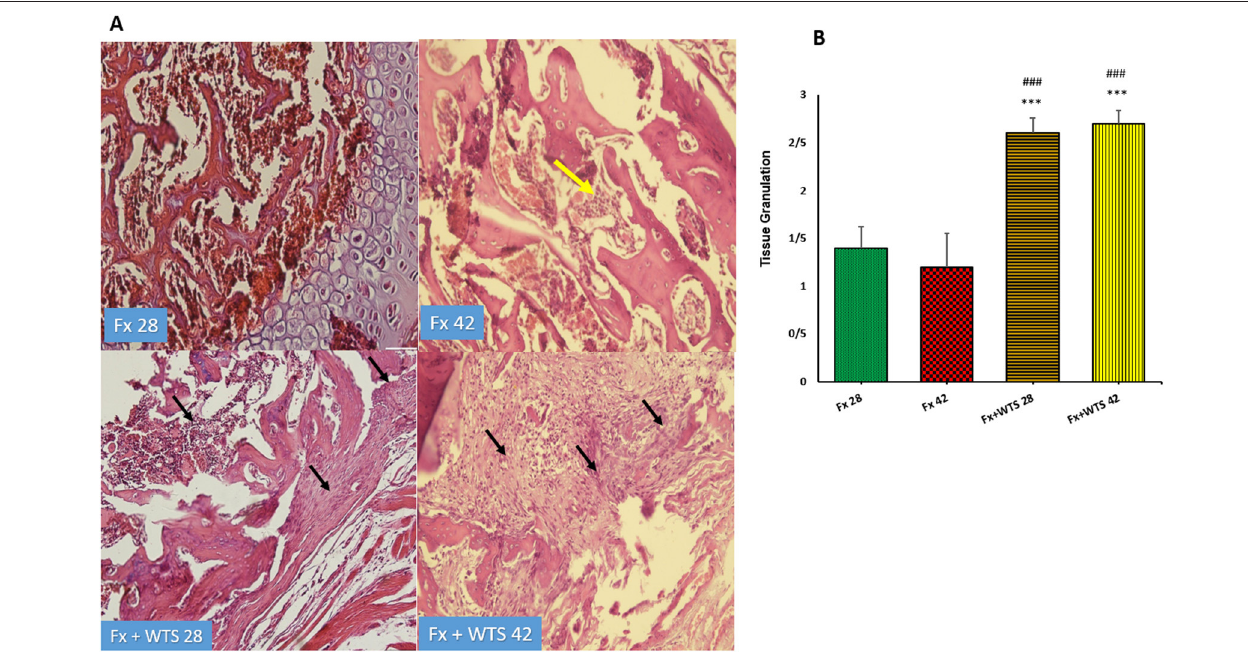
FIGURE 8 | (A) Pathological representation of tissue granulation. In the Fx 28 group, tissue granulation is rare. In the Fx 42 group, the yellow arrow indicates that the tissue granulation has been removed and the bone marrow has been replaced. In the Fx + WTS 28 group, a tissue granulation fracture is observed, which is in the early stages of the healing process (black arrow). In the Fx + WTS 42 group, the black arrow indicates the fibrosis of the non-union, and tissue granulation has changed to fibrotic tissue (black arrow). (B) The quantification of the pathologic findings regarding tissue granulation in experimental groups. Fx 28: group subjected to room air for 28 days after surgery and a femoral bone fracture, Fx 42: group subjected to room air for 42 days after surgery and a femoral bone fracture, Fx + WTS 28: group subjected to WTS for 28 days after surgery and a femoral bone fracture, Fx + WTS 42: group subjected to WTS for 42 days after surgery and a femoral bone fracture. The results are presented as mean ± SEM, n = 10. *** P < 0.001 vs. Fx 28; ### P < 0.001 vs. Fx 42.